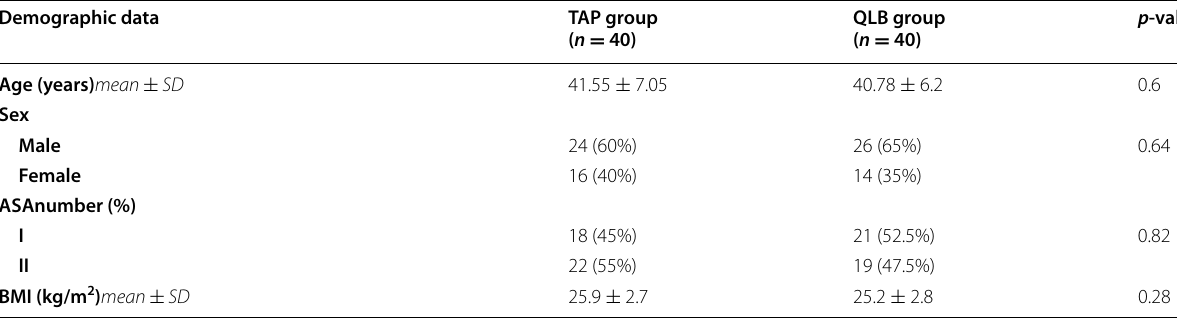
Data expressed as mean SD, proportion, t Student t -test, χ 2 chi-square test, TAP Transverses abdominis plane block, QLB Quadratus lumborum plane block, ASA ± American Society of Anesthesiologists, BMI Body mass index, p -value > 0.05 is considered non-significant